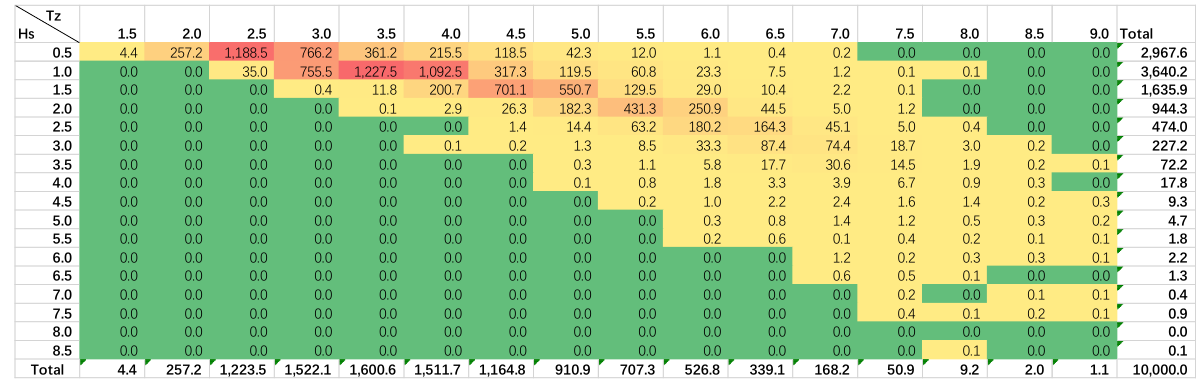
Figure 17. Wave scatter diagram at Site D.